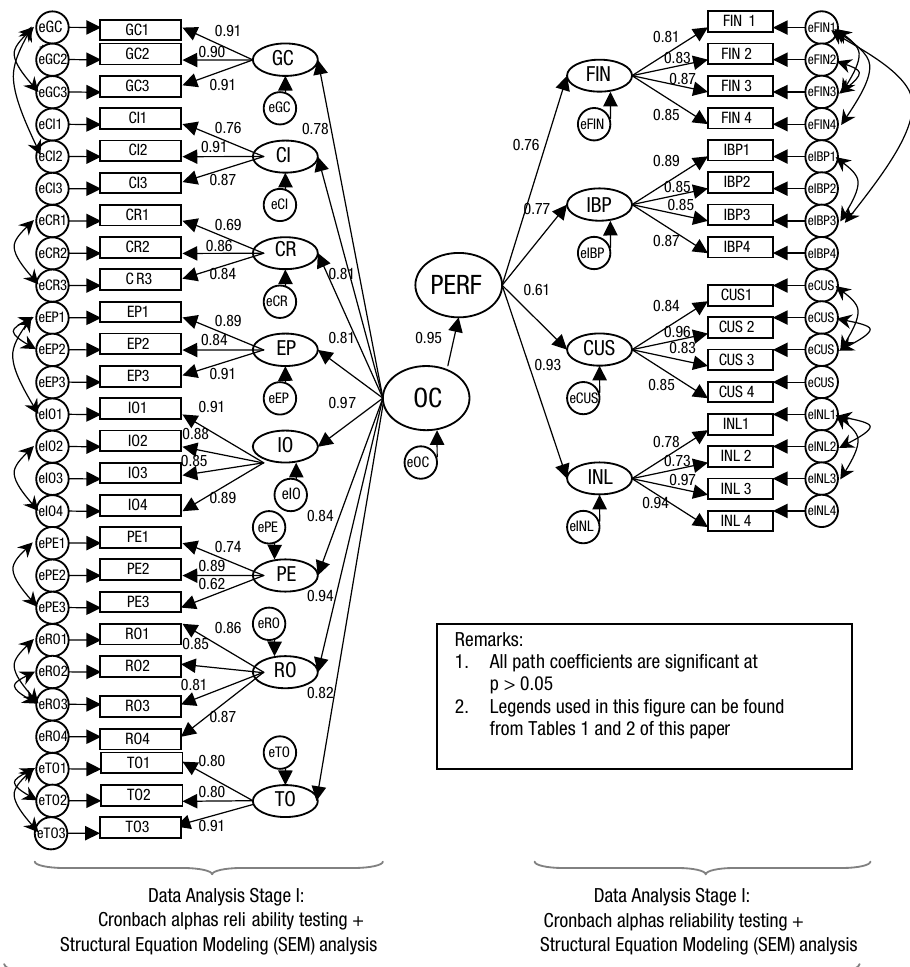
Fig. 1. Final SEM of the OC-Performance relationship